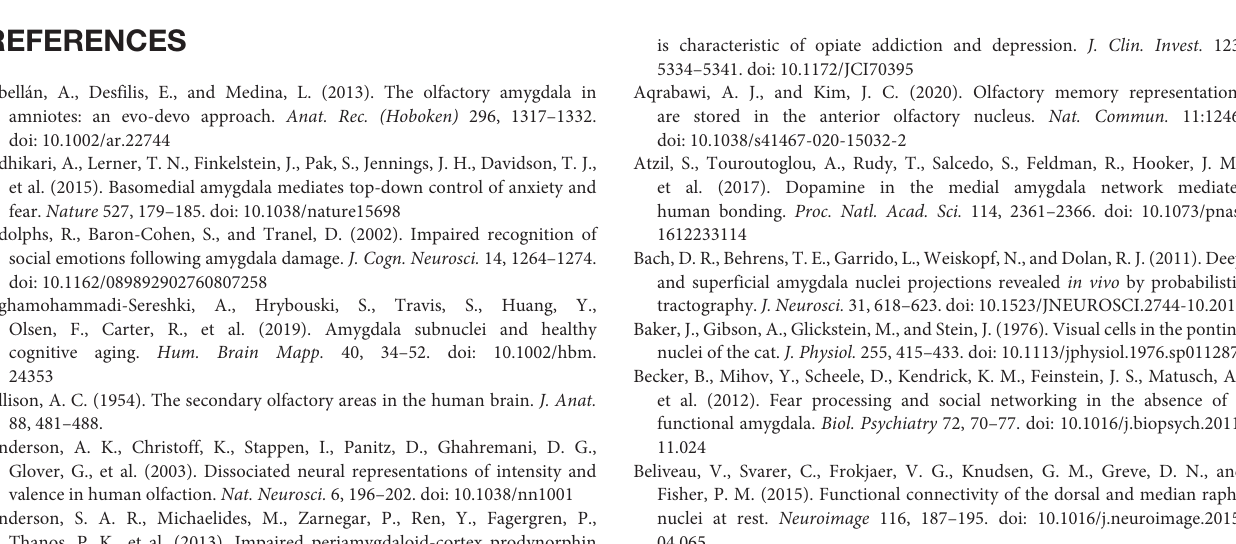
SUPPLEMENTARY FIGURE 1 | K-means parcellation of the olfactory amygdala subregions based on resting state connectivity. When k is set to values that do not directly correspond to the number of olfactory subregions, overlap between olfactory amygdala subregions and clusters is reduced. When k is set to 6, the clusters tightly align to the three olfactory amygdala subregions on the left and right sides. SUPPLEMENTARY FIGURE 2 | Maps of voxels with significant resting state connectivity with olfactory amygdala subregions. In contrast to Figures 4 – 6 , which show areas of distinct connectivity with each subregion, these maps show the complete whole-brain network for each subregion. R, Right hemisphere; L, Left hemisphere; P, Posterior; A,